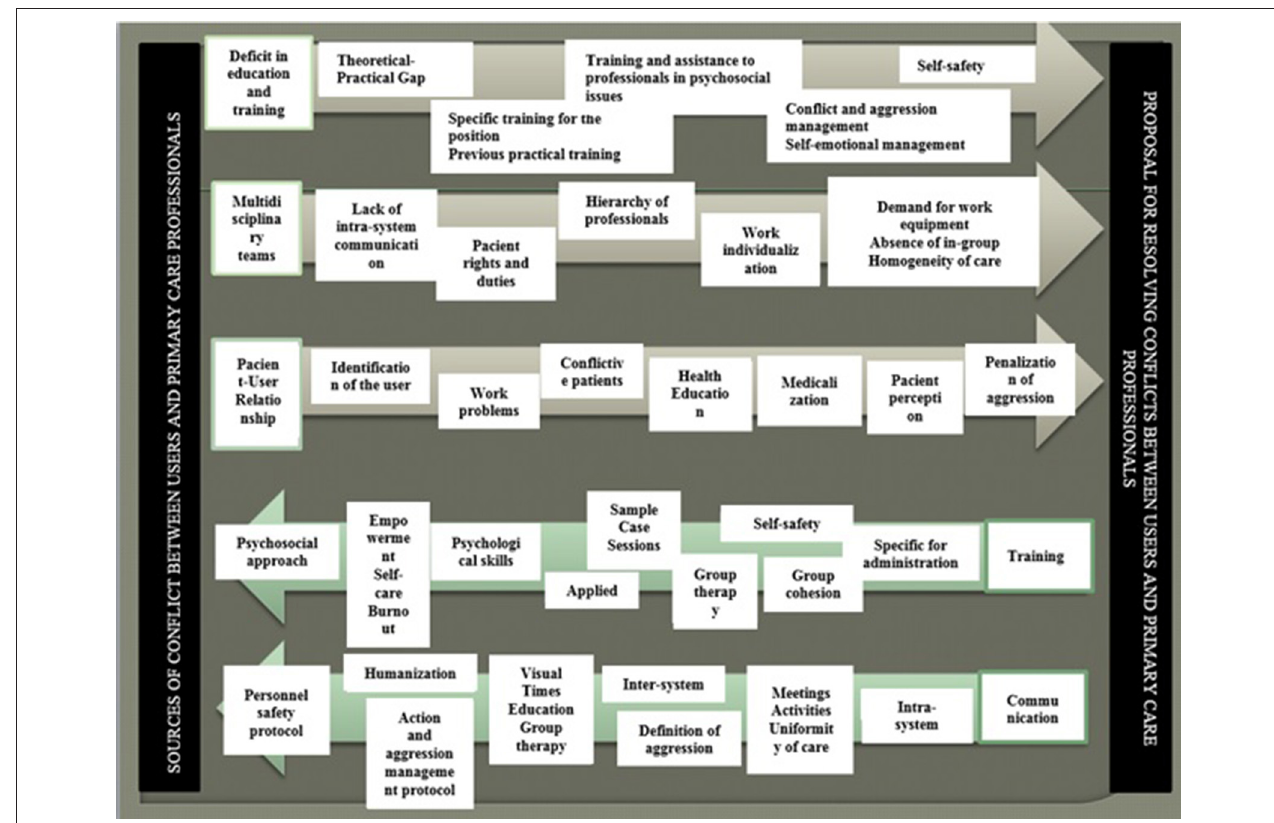
FIGURE 1 | Sources of conflict and possible solutions in primary care centers from the professional’s perspective: topics and